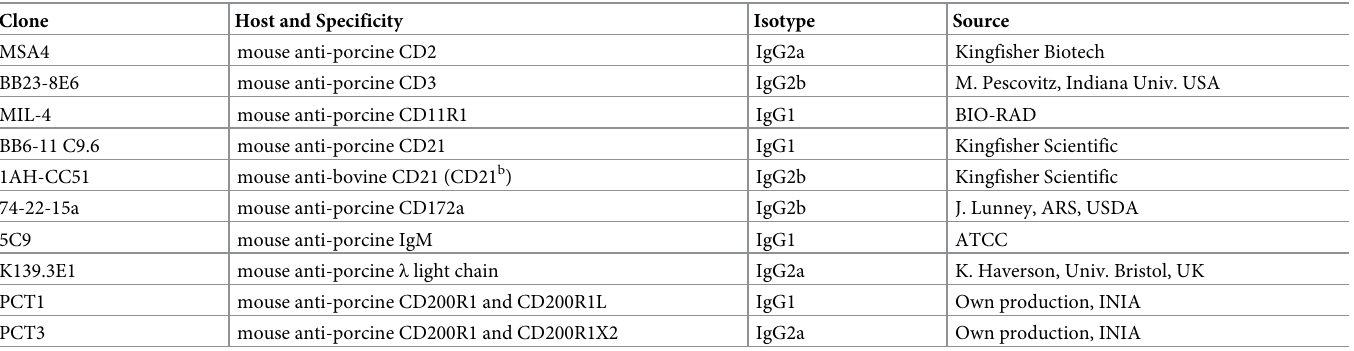
Table 1. Characteristics of mAbs used in this study.